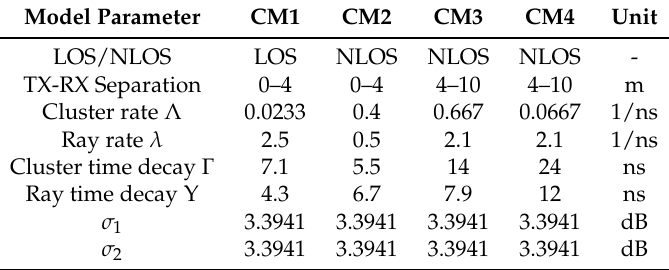
Table 3. UWB channel model parameters.